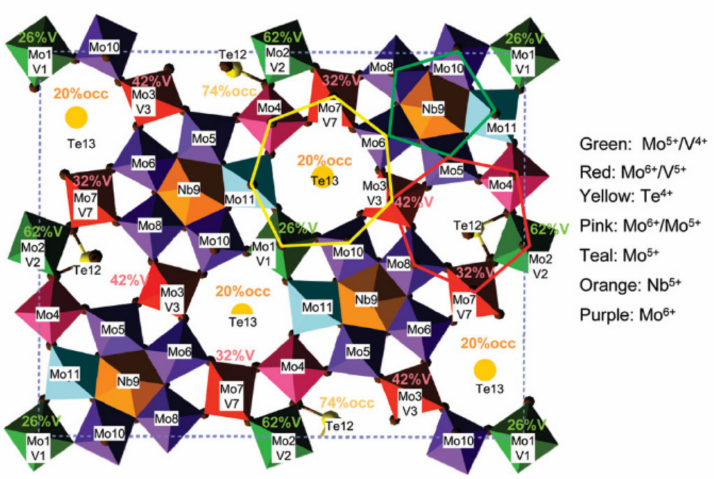
Figure 7. The rendering of the model M1 structure from simultaneously refined powder X-ray and neutron data. Adapted from ref. [76], Copyright (2008), with permission from the American Chemical